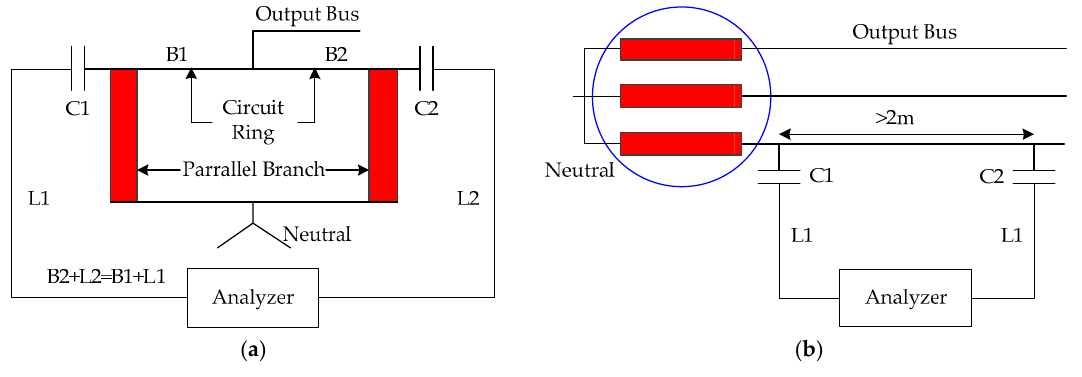
Figure 6. HVCC ( a ) differential PDA; ( b ) directional PDA [51].